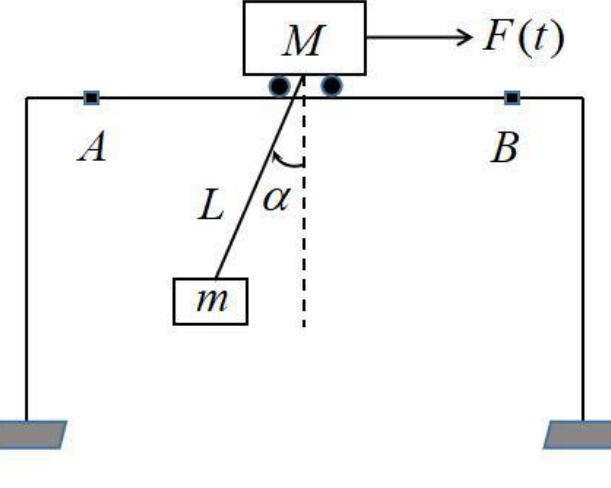
Figure 1. Abstract physical model of